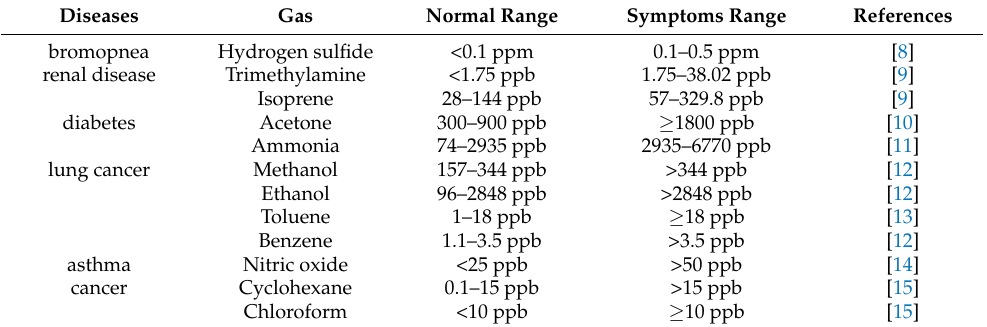
Table 1. The relationship between the types and concentrations of exhaled gas and human